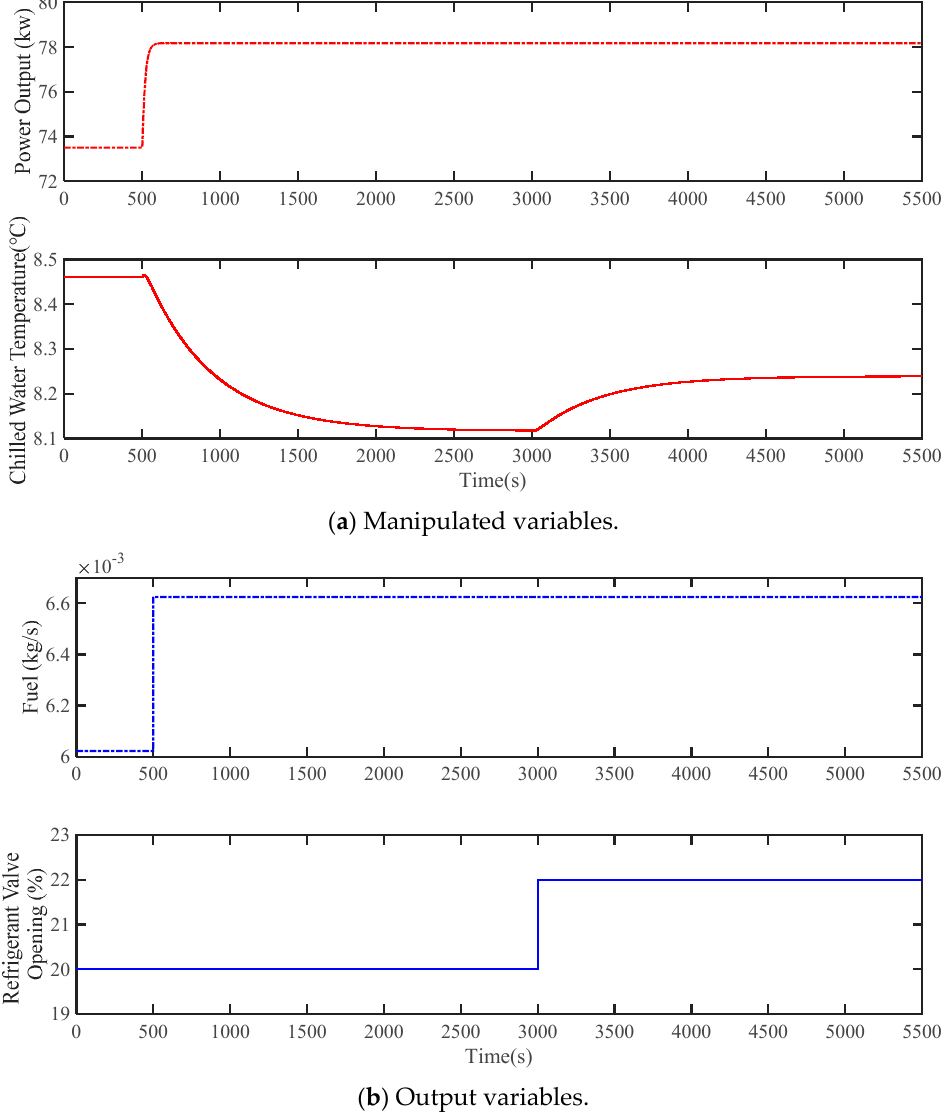
Figure 2. Step response of MGT-CCP system: Fuel and valve openings increased by 10% at 500 s and 3000 s, respectively.